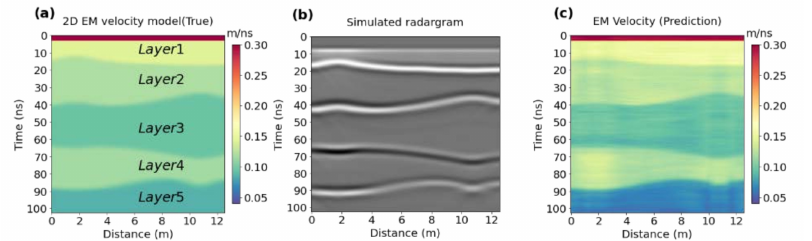
Figure 6. ( a ) The simple 2D synthetic EM velocity profile, ( b ) the simulated 2D synthetic GPR data, and ( c ) the predicted EM